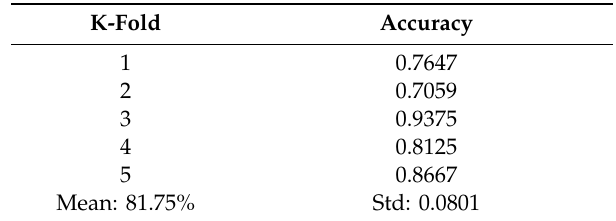
Table 1. Accuracies achieved by performing 5-Fold Cross-Validation on the Logistic Regression (LR) model.